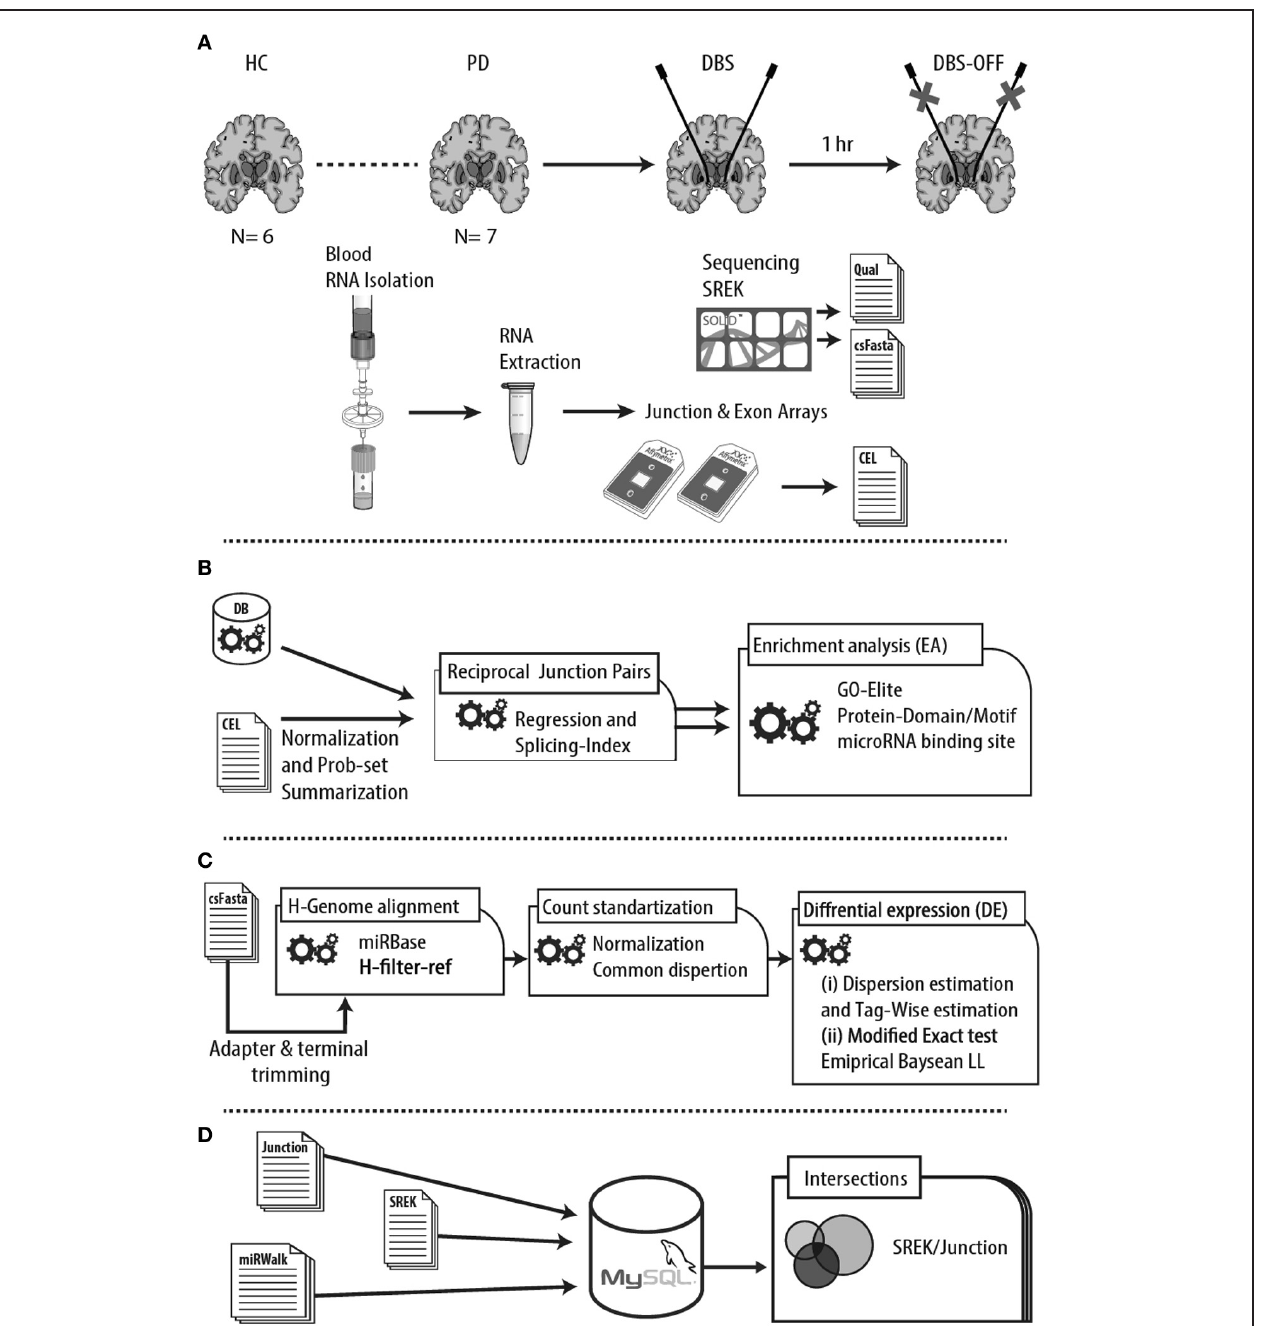
FIGURE 1 | Experimental design and analysis flow. (A) RNA was prepared from filtered blood leukocytes isolated from whole blood samples of PD patients 1 day prior to DBS (PD), and post-DBS upon clinical stabilization, both on (DBS-ON) and following 1h off electrical stimulation (DBS-OFF). Age- and gender-matched male healthy volunteers served as a control group (HC). Small RNA libraries were prepared using a Small RNA Expression Kit (SREK) and constructed according to the manufacturer’s instructions. cDNA of patients pre- and post-DBS on stimulation and controls was also applied to Affymetrix human exon and junction prototype microarrays (HJAY). (B) The junction array datasets were processed in AltAnalyze using a previously described regression